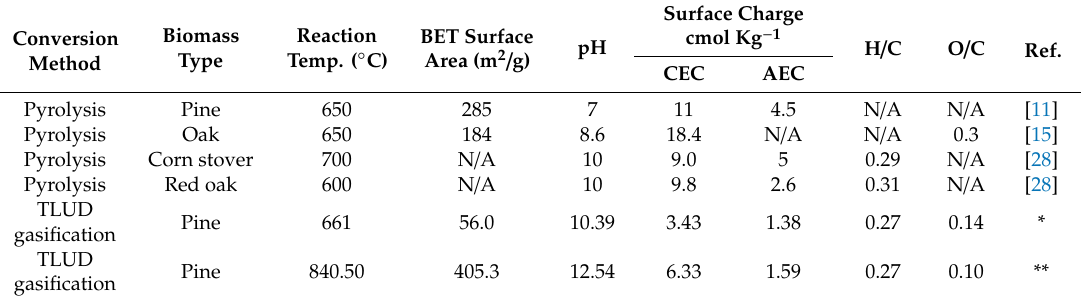
Table 2. Properties of biochars produced under different conversion methods. BET: Brunauer- Emmett-Teller; CEC: Cation Exchange Capacity; AEC: anion exchange capacity; TLUD: Top-lit Updraft.